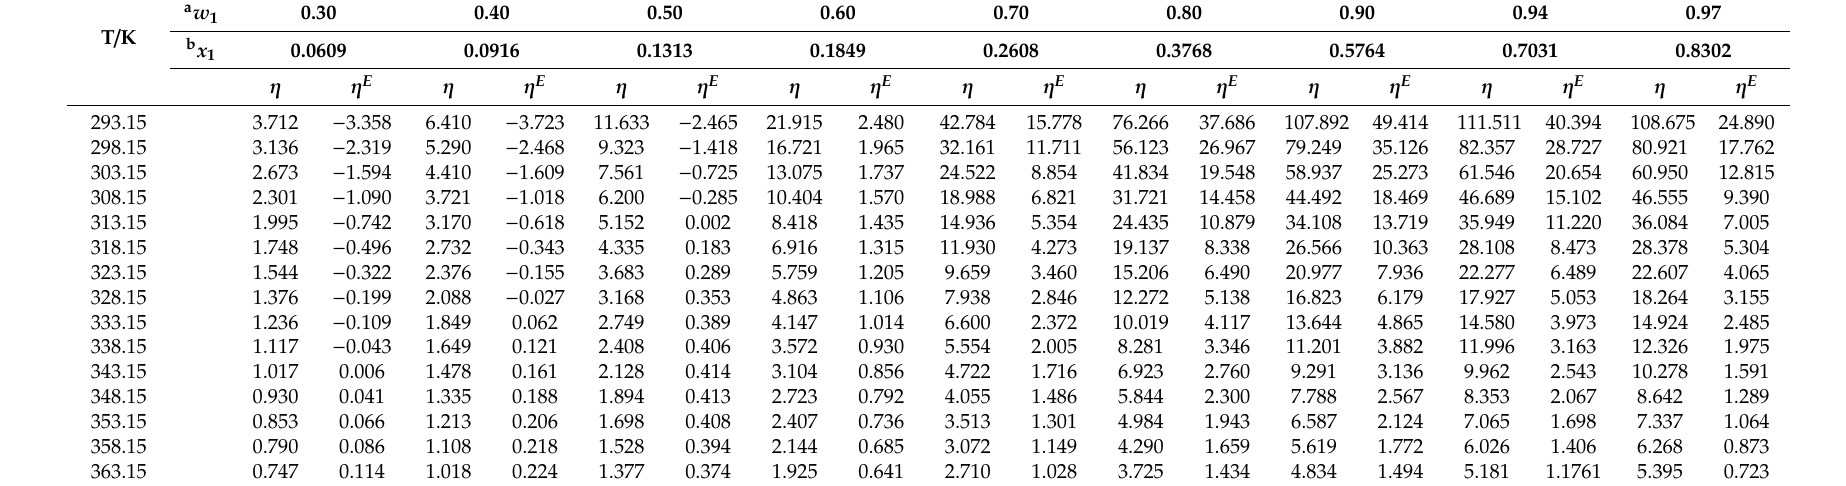
Table A5. Measured viscosity ( η / mPa · s) and deduced viscosity deviation ( η E / mPa · s) of MDEA (1) + H 2 O (2) mixtures.